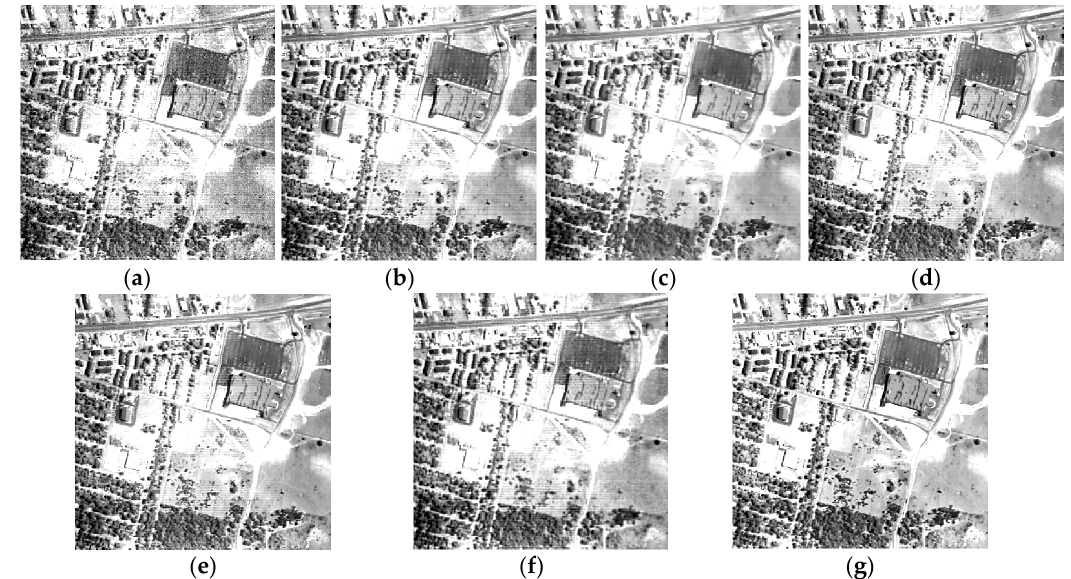
Figure 7. Denoised results by different methods of the 206 th band in an urban dataset: ( a ) original, ( b ) HyRes, ( c ) LRTV, ( d ) LRMR, ( e ) NAILRMA, ( f ) LRTDTV, and ( g ) proposed.